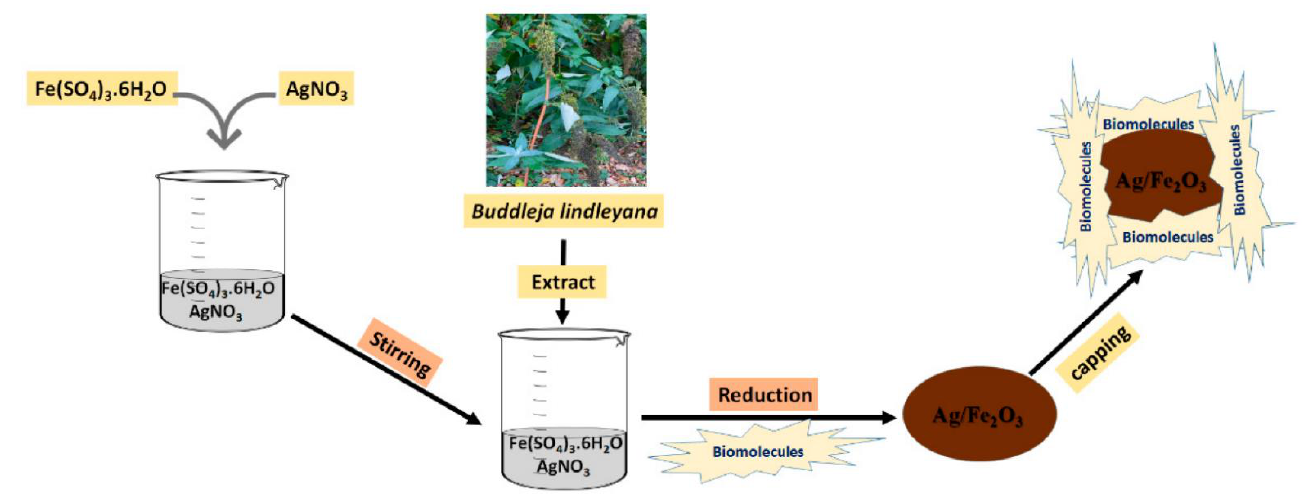
Figure 2. The reduction procedures of the Ag/Fe 2 O 3 nanocarrier for loading biomolecules [66]. The exceptional electrochemical redox capabilities of magnetic nanoparticles may Poly (ethylene glycol) and poly(ε -caprolactone) disulfide bonds (PEG SS PCL) were used to create biodegradable reduction-responsive micelles for the administration of super-paramagnetic iron oxide (SP IO) nanoparticles and doxorubicin (a copolymer has redox reaction characteristics. Doxorubicin (DOX) was loaded 32% throughout magnetic nanomicelles. Consolidation of self-assembled PEG-PCL micelles with oleic acid and water was achieved using coarse-grained molecular dynamics (CG- MD) modeling. In comparison, the hydrophobic and hydrophilic proportions of each copolymer block were identical, and each oleic acid was similarly attached to magnetic nanomaterials [74]. To modulate camptothecin pharmaceutical discharge from the mesoporous silica pathways and achieve a dynamic dual-mode MRI contrast, researchers employed superparamagnetic iron oxide nanoparticles (SPION) coated by acid, oxidation stress, and redox-sensitive manganese oxide (MnOx). The efficiency of responsive therapy has been tested throughout pancreatic tumor cells and tumor-bearing animals, and results have supported the performance of Non-vehicle MnOx-SPION@MSn@CPT fighting cells [75]. To further improve biodistribution and efficacy for convection-enhanced delivery (CED) of BG to GBM, iron oxide superparamagnetic nanomaterials were developed. The nanomaterials (NPCP-BG-CTX) consist of a magnetic core surrounded by a surface coating of redox-responsive chitosan-PEG copolymer altered by BG covalent attachment and peptide chlorotoxin tumor (CTX). NPAC-BG-CTX demonstrated precise in vitro BG transport in human GBM cells under decreased intracellular circumstances, allowing for controlled and targeted BG discharge. MGMT activity and TMZ toxicity were significantly reduced in cells administered with NPCP-BG-CTX. Animal studies in mice with primary human GBM xenografts showed that CED from NPCP-BGCTX had good in vivo distribution volume (Vd). When NPCP-BG-CTX and NPCP-CTX were used in conjunction, the mean survival rate in both medicated and unprotected animals increased by three times [76]. Enzymes are widely used by internal stimulus-responsive nanocarriers since they are involved in a wide range of biochemical and physiological mechanisms. Enzyme transcription at specific places is critical in a variety of pathological processes. In addition to indicating a sick condition, it may also be modified to transport medications with more safety to the appropriate region and serves as a possible screening tool [33]. In contrast to other stimuli, enzymatic processes are more powerful, efficient, and accurate, providing extra benefits by intracellularly participating in various metabolic reactions. The transcription of enzymes, including proteases, phospholipases, hydrolases, and